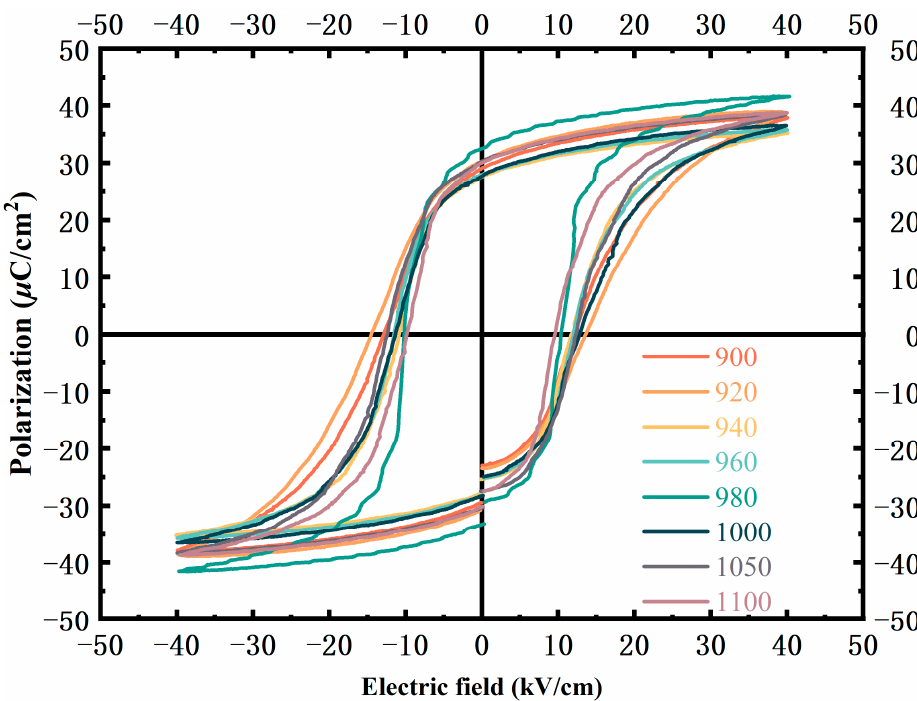
Figure 5. Ferroelectric hysteresis loop under 40 kV/cm.